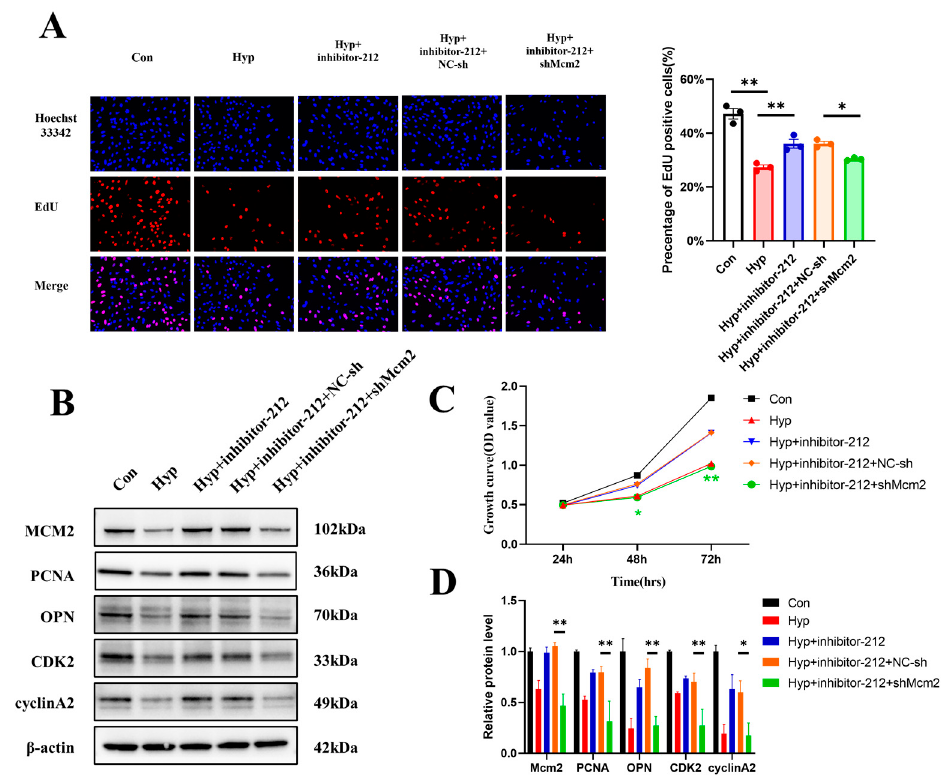
Figure 7. miR-212-3p attenuated hypoxia-induced cell cycle progression and cell proliferation inhibition by regulating MCM2. ( A ) The EdU (red) assay was used to examine cell proliferation ( n = 3). EVOS M5000 objective magnification: 20×. ( B , D ) Western blot analysis of MCM2, PCNA, OPN, CDK2, and cyclin A2 ( n = 3). ( C ) Cell proliferation was evaluated by a CCK-8 assay ( n = 3). The symbol * (green) represents Hyp + inhibitor-212 + shMcm2 vs. Hyp + inhibitor-212 + NC-sh. Data are shown as the mean ± SEM, * p < 0.05, ** p < 0.01.